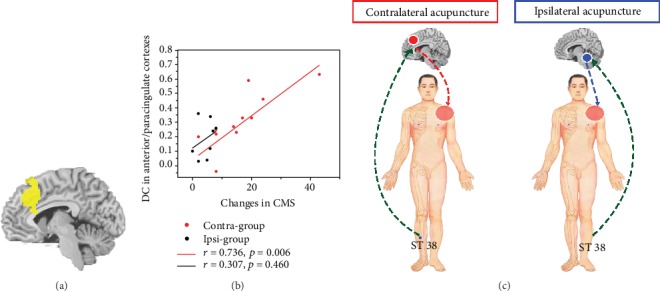
Correlation between the Constant–Murley scores (CMS) and degree centrality (DC) values in the anterior/paracingulate cortex and schematic summarizing CSP response to acupuncture treatment in contralateral or ipsilateral acupoint. (a) The anterior/paracingulate cortex mask with significant treatment-related DC changes in the contra-group. (b) Scatter plot between the treatment-related changes in CMS and DC in the contra-group and the ipsi-group. (c) Schematic of the different mechanisms of acupuncture at the contralateral and ipsilateral ST 38 for CSP. While acupuncture at the contralateral acupoint can improve shoulder function and alleviate pain via indirect regulated the anterior/paracingulate cortex, ipsilateral acupuncture can alleviate pain via the cerebellum. Red dots: contra-group; black dots: ipsi-group.